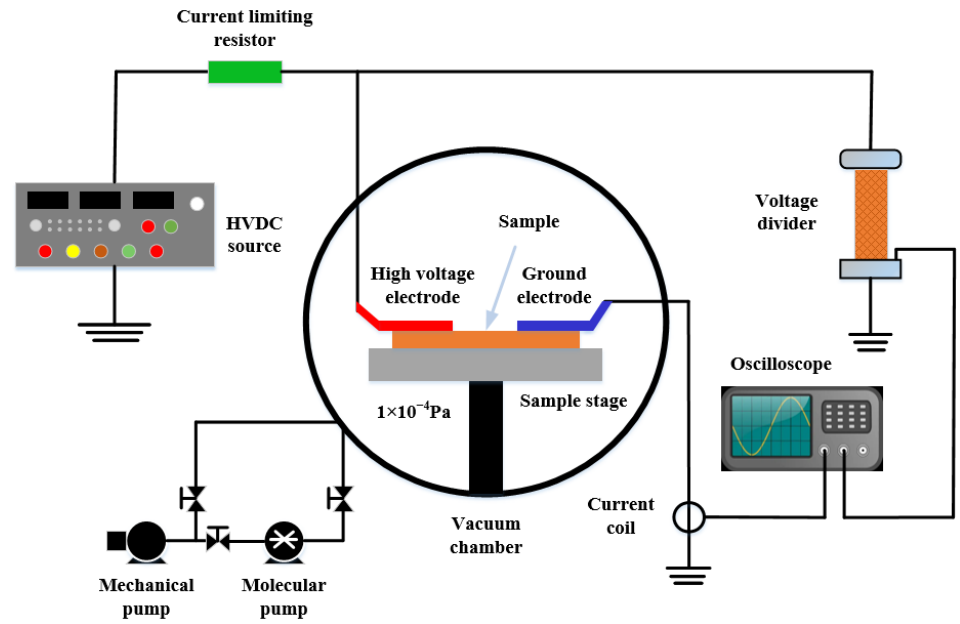
Figure 3. Vacuum surface flashover platform.